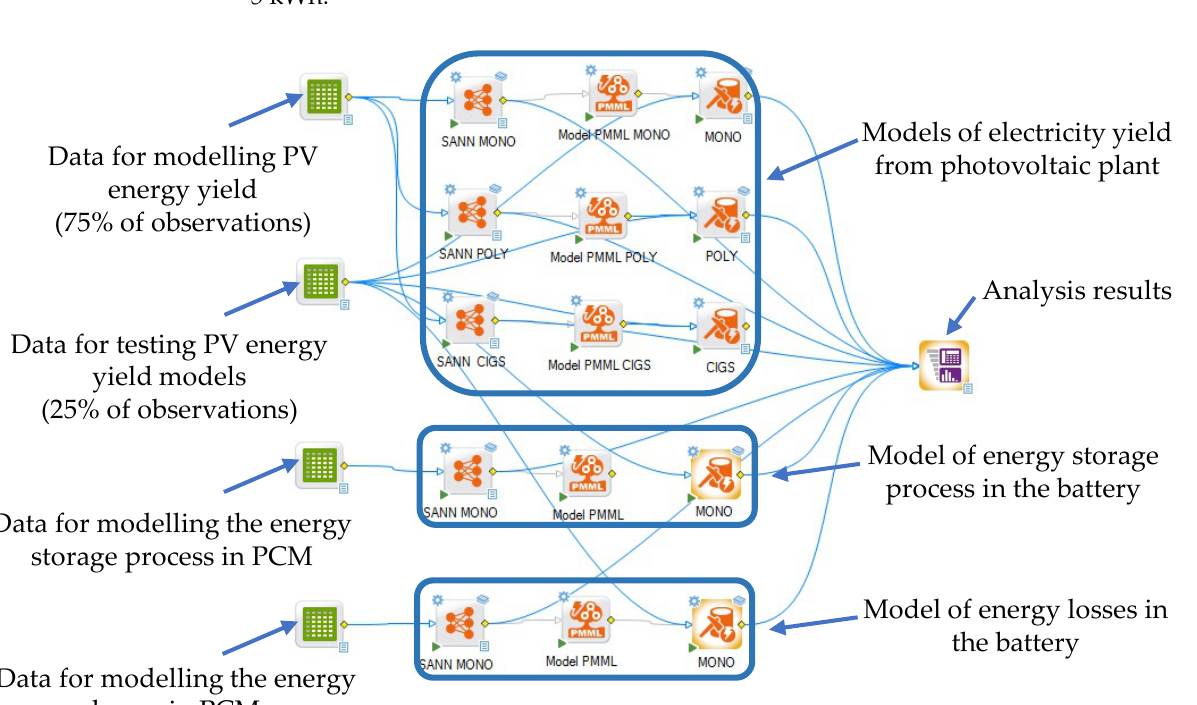
Figure 8. Models of energy storage from photoelectric conversion in the form of internal energy of the deposit in the Data Miner workspace.